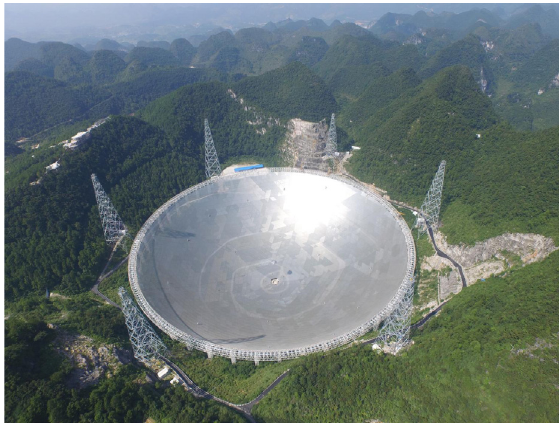
Figure 5. FAST Telescope operated by NAOC in Guizhou,